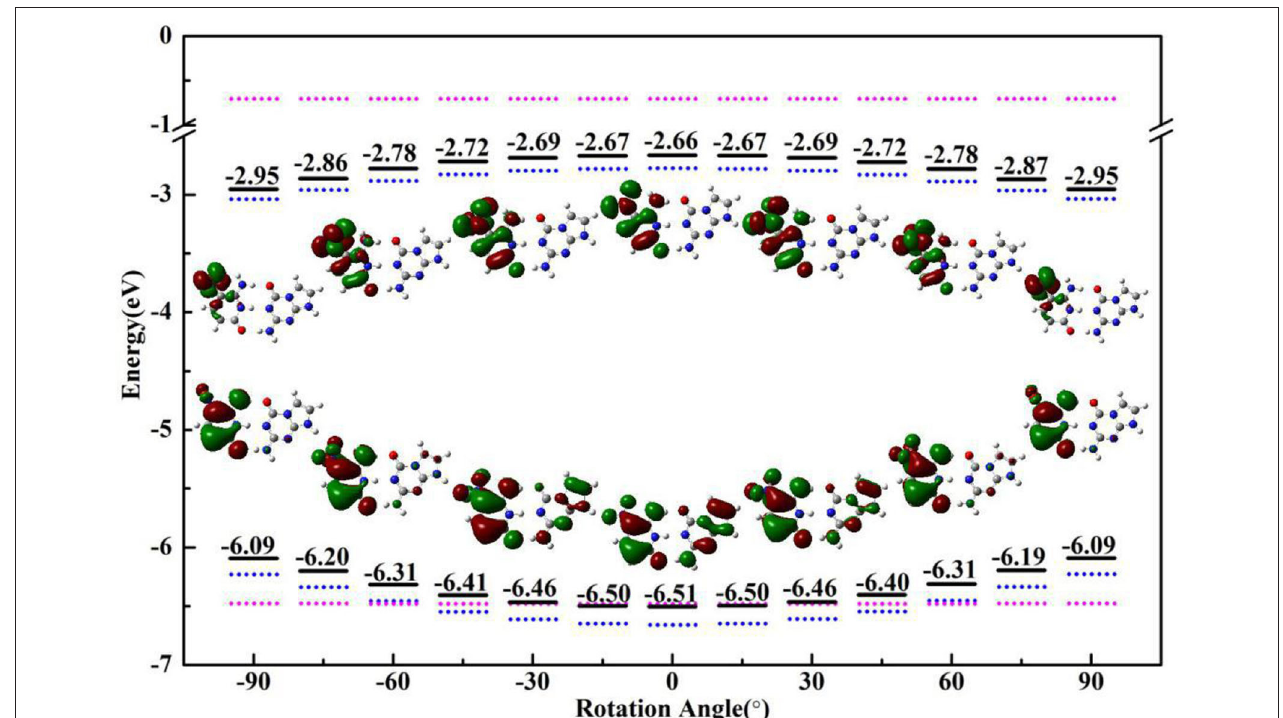
FIGURE 4 | The HOMO/LUMO energy and electron distribution of ZP (black solid line), single Z (blue dotted line) and P (pink dotted line) with the rotational displacements of − 90 ◦ , − 60 ◦ , − 30 ◦ , 0 ◦ , 30 ◦ , 60 ◦ , 90 ◦ .